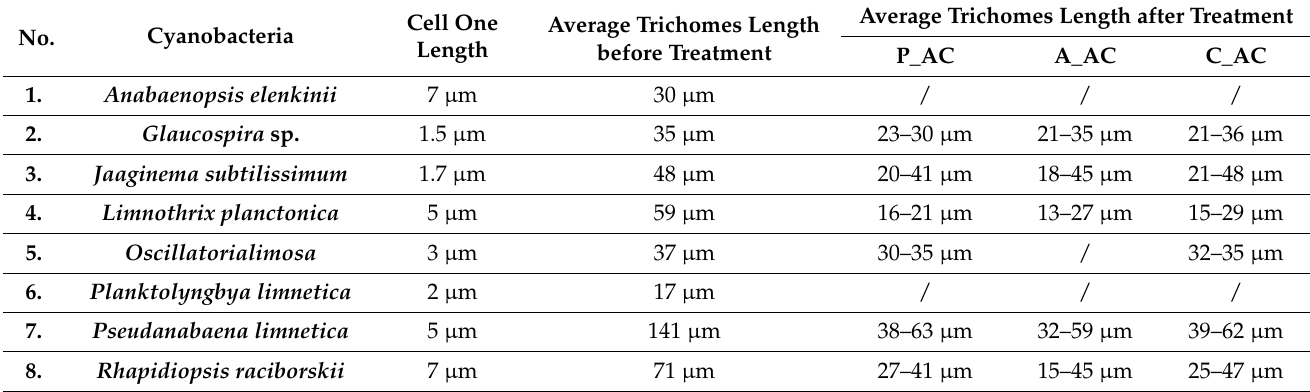
Table 8. Analysis of trichomal Cyanobacteria in water from Aleksandrovac Lake before and after treatment of activated carbons in August